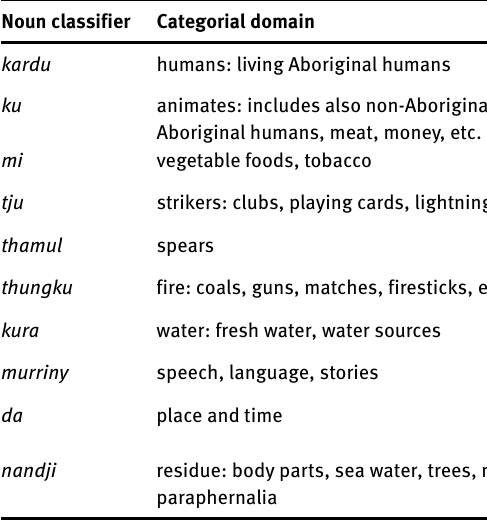
Table 4: Murrinh-Patha’s 10 nominal classes and some content question words specific to those